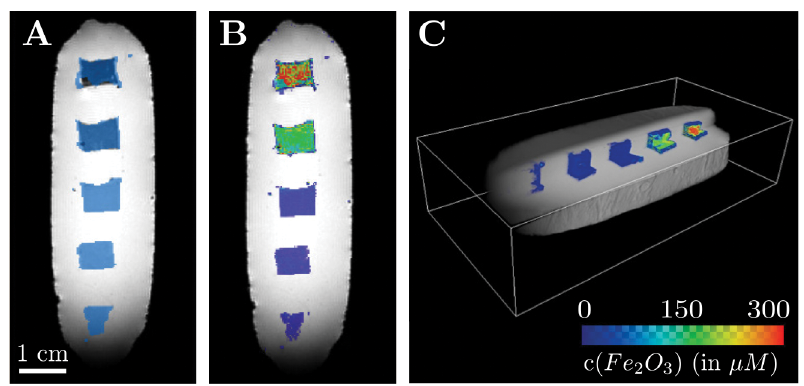
Fig 4. Overlay of the MRI magnitude data (grayscale) and the results of the SVM-based localization method for an agarose block phantom (color-coded). A: Result of the C-SVC in the medial plane of the block phantom. Voxels classified as containing labeled cells are colored in blue. B: Corresponding iron oxide concentration map. C: 3D concentration map with corner-cut. The colorbar applies to B and C.